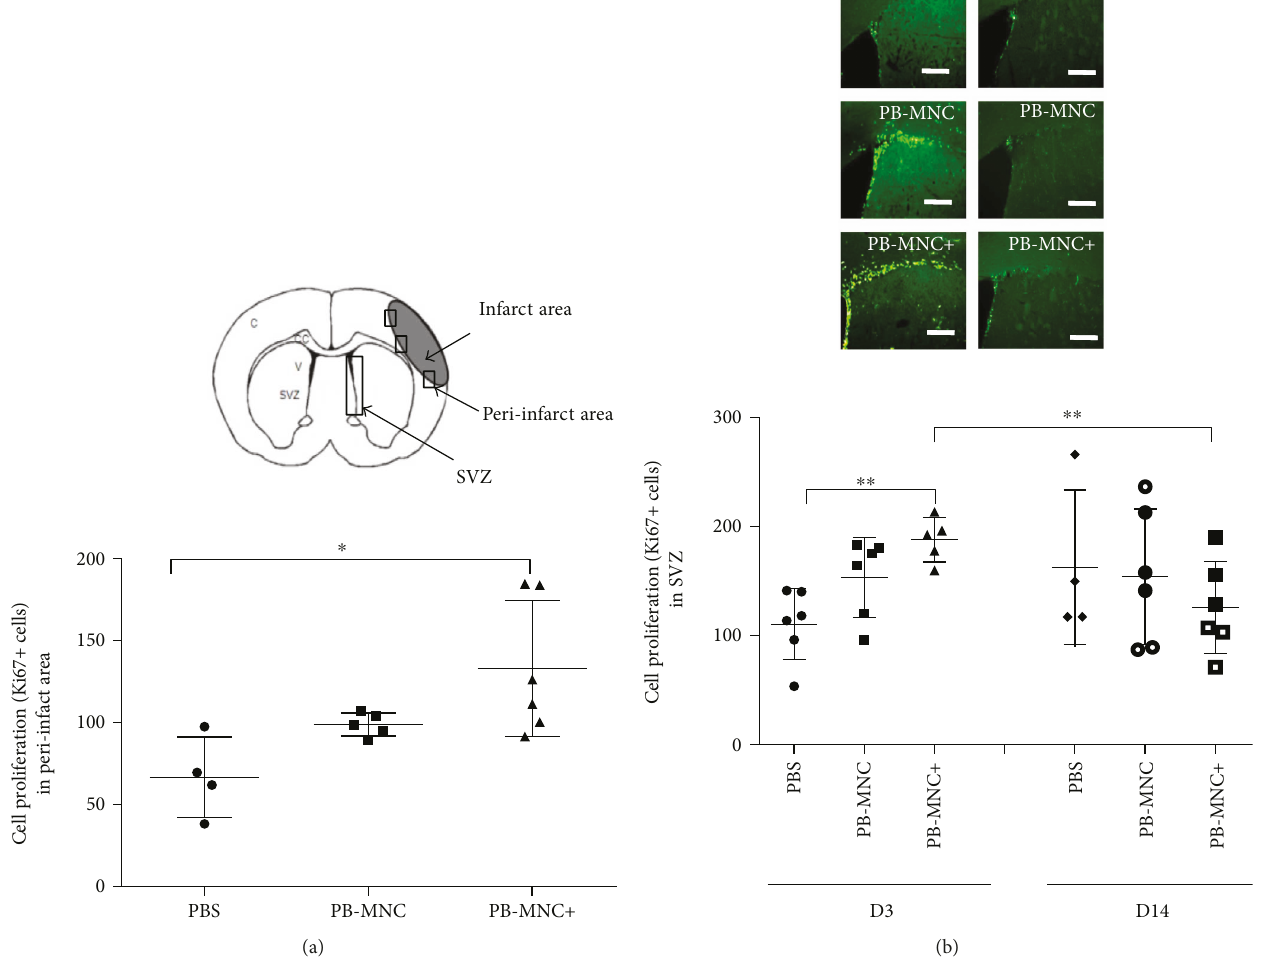
Figure 3: Ephrin-B2-stimulated diabetic PB-MNC promote cell proliferation poststroke. (a) In the peri-infarct area at D3, Ki67+ cell numbers were signi fi cantly greater in the PB-MNC+ group versus the PBS group, but there were no signi fi cant di ff erences between the PB-MNC group and the other two groups ( N = 4 – 6 /group). (b) In the subventricular zone at D3, there was a signi fi cant increase in Ki67+ cells in PB-MNC+-treated mice compared to PBS-treated mice ( N = 5 – 6 /group). By D14, no signi fi cant di ff erences were evidenced between PB-MNC+, PB-MNC, and PBS ( N = 4 – 6 /group). There were no signi fi cant di ff erences between D3 and D14 in the PBS and PB-MNC groups, whereas there were signi fi cantly fewer Ki67+ cells in the PB-MNC+ group. Data are presented as mean ± SD. ∗ P < 0 05 ; ∗∗ P < 0 01 . Scale bar =200 μ